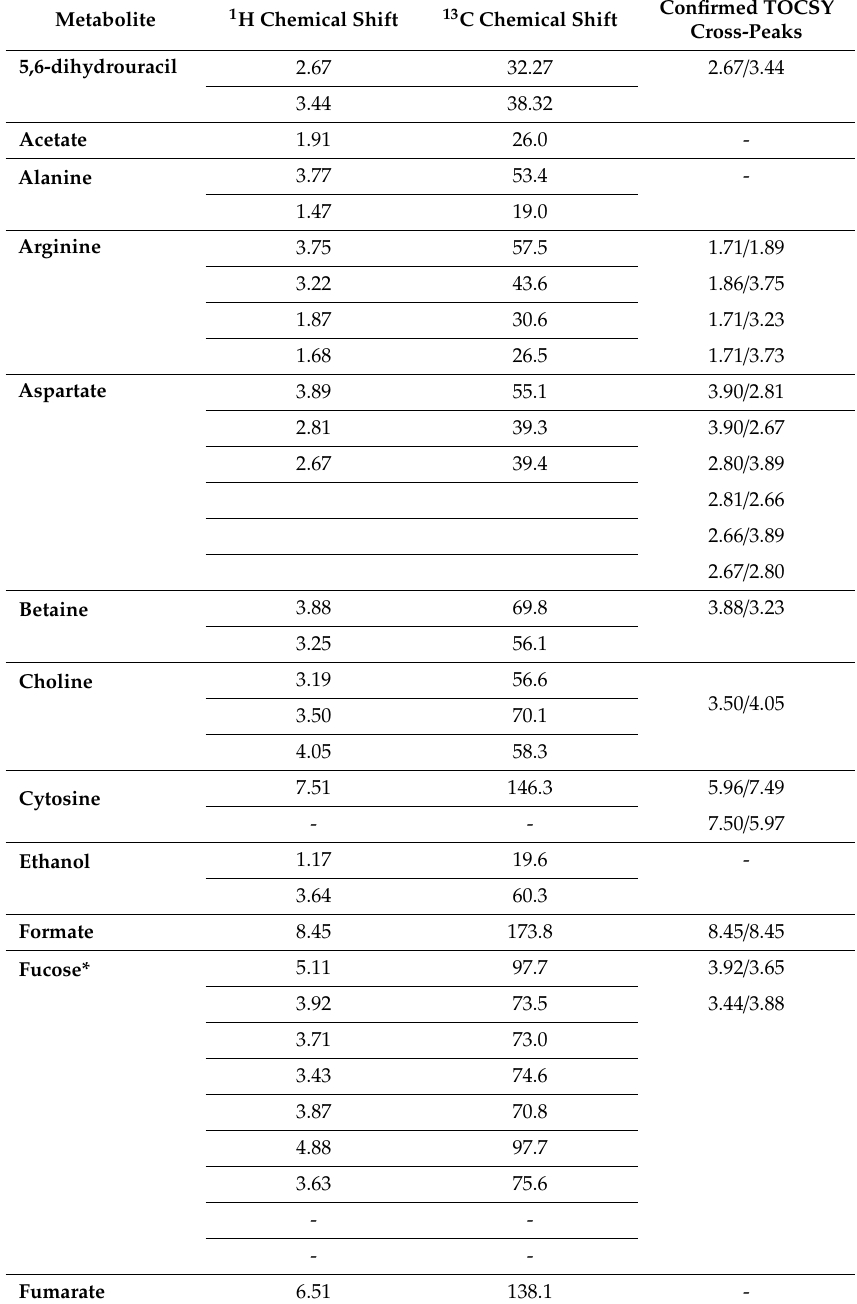
Table A2. Five-month-old fecal